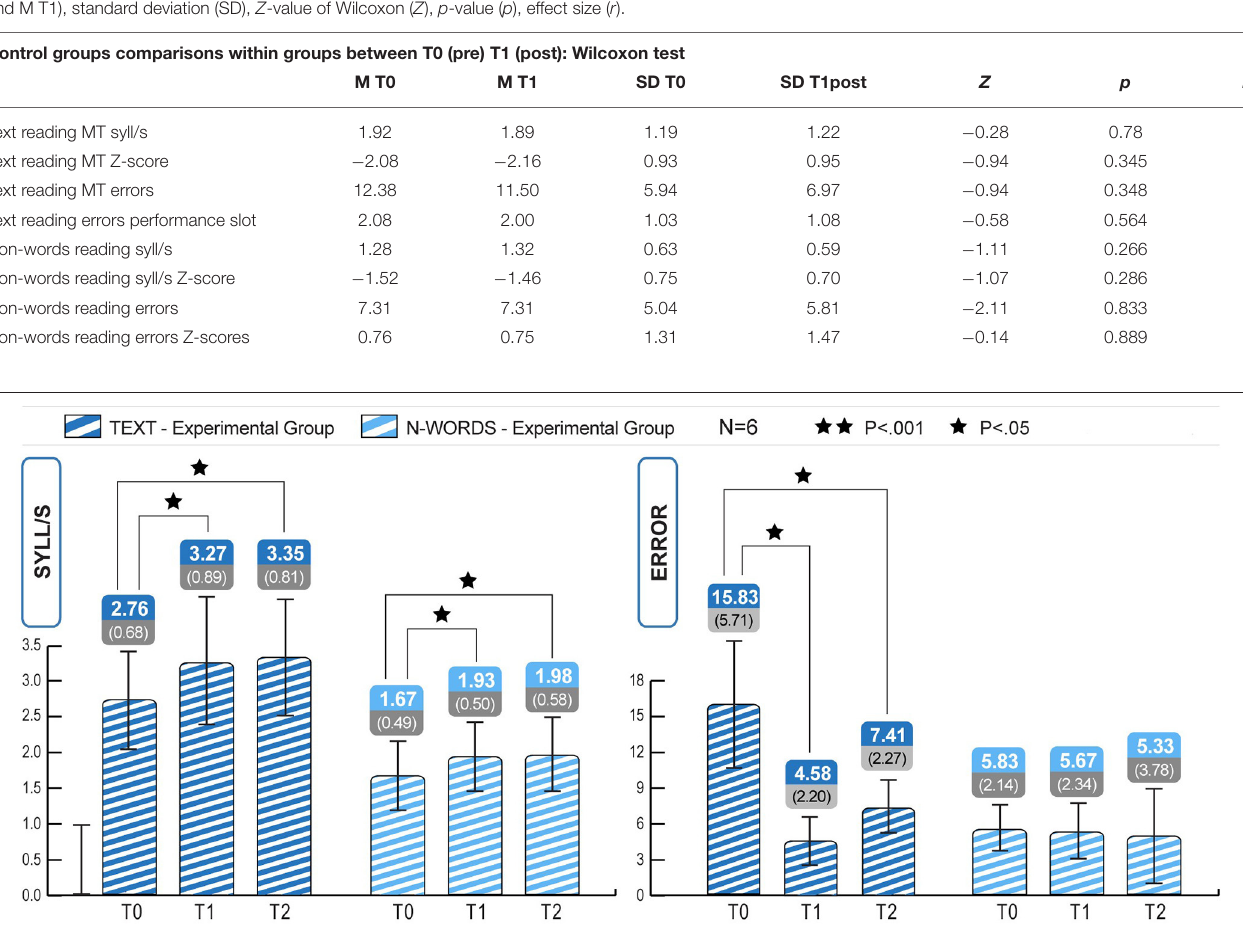
FIGURE 3 | Experimental group, within subjects comparisons. Significant increase in text speed and accuracy from T0 to T1 and from T0 to T2 and in non-words speed from T0 to T1 and from T0 to T2 ( Tables 5 , 7 ). Statistical differences are marked according to the p -values at Wilcoxon test on Z scores. No significant change of the improvement obtained in T1, compared to the measures at T2 (all p >